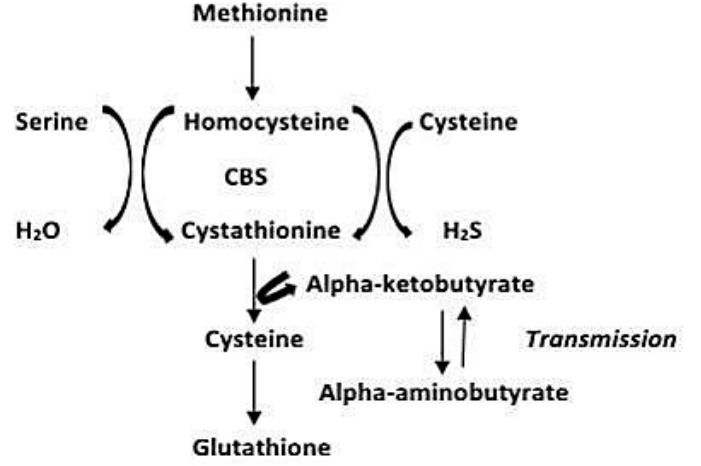
Figure 6. The pathway showing the metabolism of homocysteine to cystathionine by using vitamin B6, and resultant formation of glutathione [69].